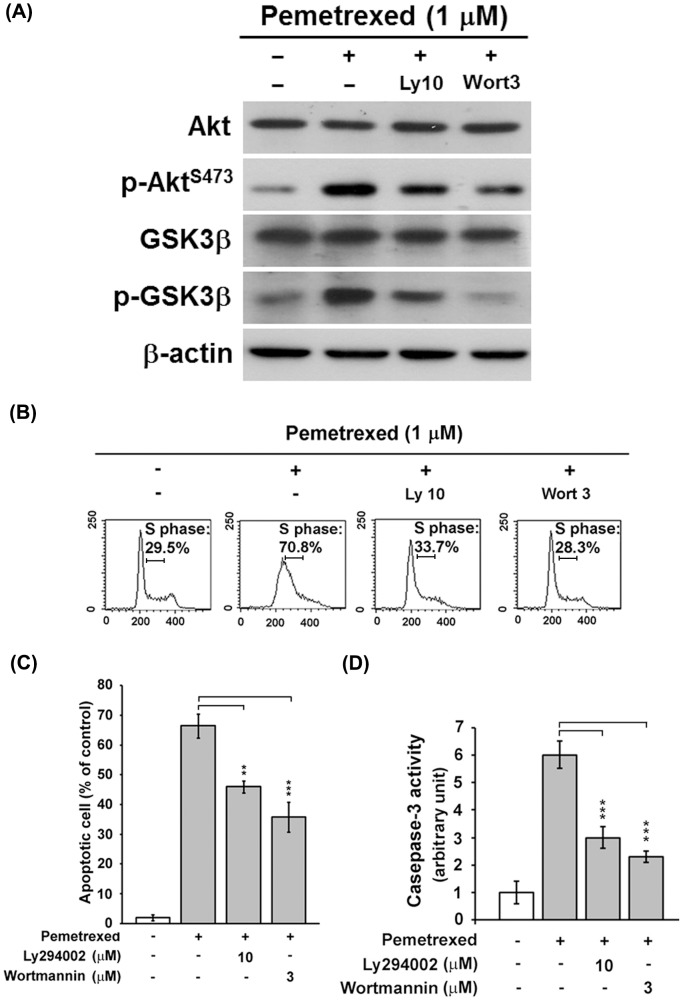
PI3K inhibitors suppress pemetrexed-induced Akt and GSK3β activation, S-phase arrest, cell apoptosis and caspase-3 activation.A549 were pretreated with 10 µM Ly294002 or 3 µM wortmannin (inhibitors of PI3K/Akt) for 2 h, and then 1 µM pemetrexed was added.(A) the levels of Akt and GSK3β and (B) the cell cycle distribution were determined for 24 h after pemetrexed treatment. (C) Cell apoptosis and (D) the caspase-3 activity were examined after 72 h pemetrexed incubation. **P<0.01, ***P<0.001.